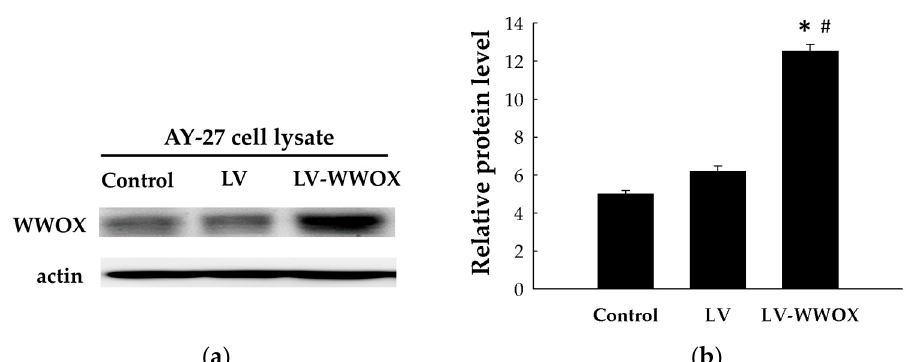
Figure 1. Establishment of WWOX-overexpressing cell lines. ( a ) AY-27 cells were infected with lentivirus overexpressing WWOX or containing the control vector. The total proteins were extracted after 48 h of infection and the concentrations were measured. Subsequently, Western blot analysis was performed to detect the expression of WWOX in the AY-27 cells. ( b ) WWOX protein expression was normalized to actin expression. The results are expressed as the mean ± SD. * p < 0.05 compared to the control groups; # p < 0.01 compared to the LV groups.